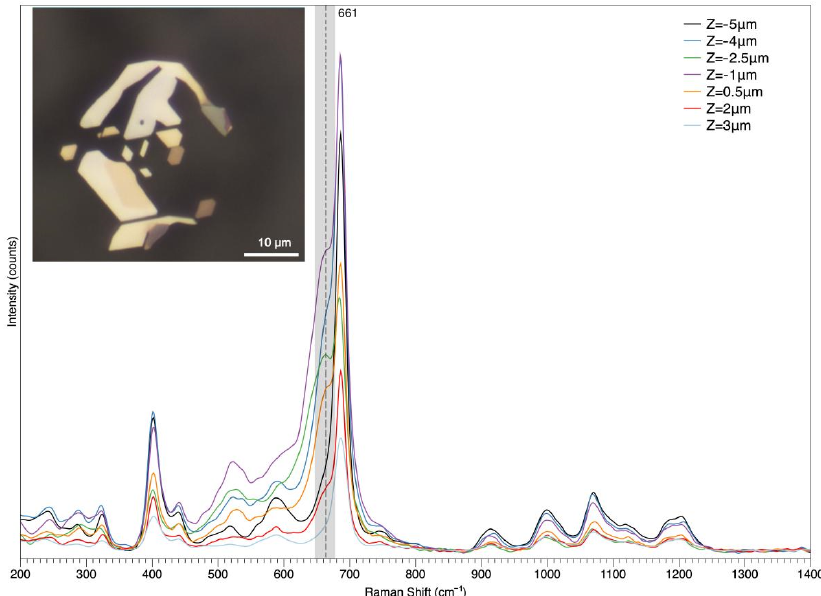
Figure 9. One magnetite was selected for Raman mapping. This figure demonstrated the strength variation in a 661 cm − 1 peak along the z -axis, ranging from − 5 μ m to 3 μ m with fi xed x and y, select- variation in a 661 cm − 1 peak along the z -axis, ranging from − 5 µ m to 3 µ m with fixed x and y, ing the 661 cm − 1 peaks as the indicative peak of magnetite. selecting the 661 cm − 1 peaks as the indicative peak of